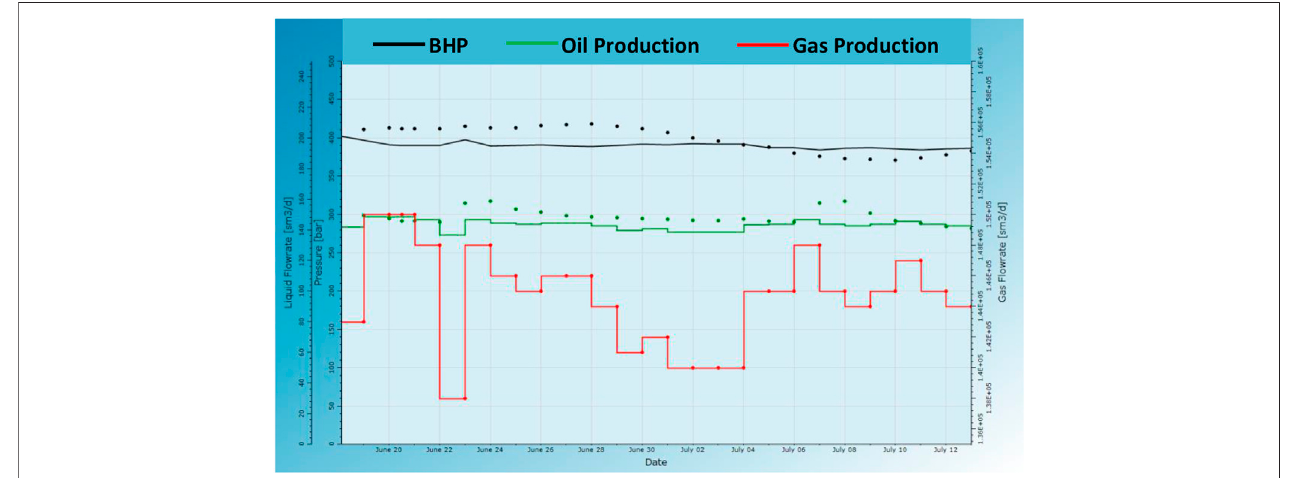
FIGURE 13 | Historical matching effect of well BZ19-6-X (Gao et al., 2020).